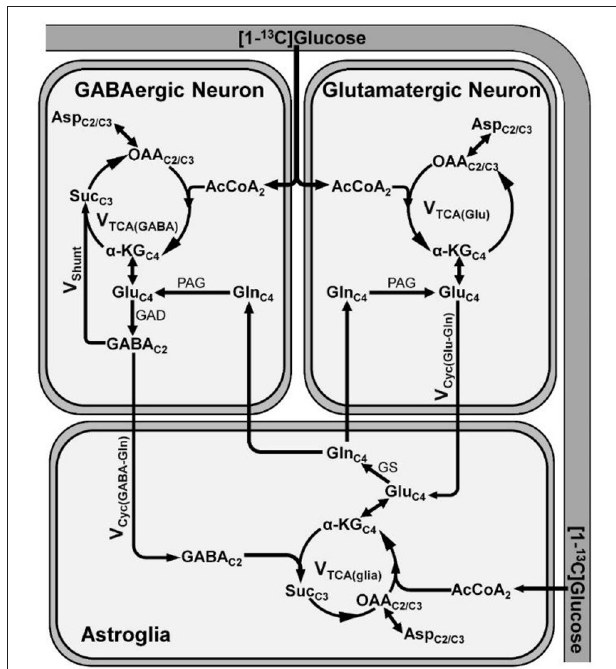
FIGURE 3 | A schematic of three compartment metabolic model showing 13 C labeling of amino acids from [1- 13 C]glucose. Metabolism of [1- 13 C]glucose via glutamatergic and GABAergic TCA cycle labels Glu C4 . In GABAergic neurons, Glu C4 is further decarboxylated to GABA C2 by glutamate decarboxylase (GAD). The labeling of Gln C4 occurs by release and uptake of Glu C4 and GABA C2 in astrocytes followed by transamination by glutamine synthetase (GS). Further metabolism of Glu C4 and GABA C2 transfers the label into Asp C2 / C3 . α -KG C4 , α -ketoglutarate-C4; AcCoA 2 , acetyl co-enzymeA-C2; Asp C2 / C3 , aspartate-C2/C3; GABA C2 , γ -aminobutyric acid-C2; Glu C4 , glutamate-C4; GAD, glutamate decarboxylase; Gln C4 , glutamine-C4; GS, glutamine synthetase; OAA C2 / C3 , oxaloacetate-C2/C3; PAG, phosphate activated glutaminase; Suc C3 , succinate-C3; V cyc(GABA − Gln) , GABA–glutamine cycling flux; V cyc(Glu − Gln) , glutamate–glutamine cycling flux; V shunt , flux of GABA shunt; V TCA(glia) , astroglial TCA cycle flux; V TCA(GABA) , GABAergic TCA cycle flux; V TCA(Glu) , glutamatergic TCA cycle